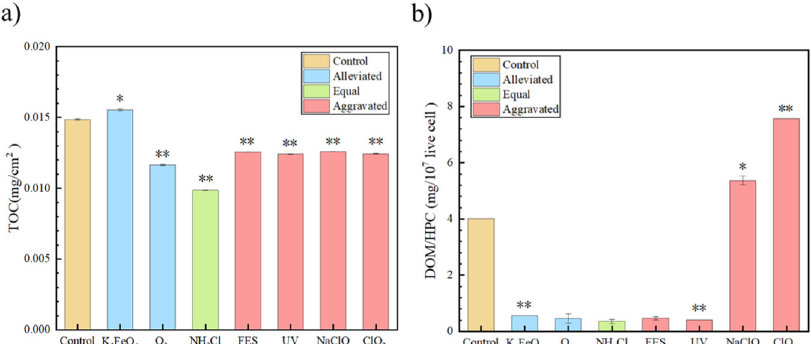
Fig. 2 DOM density in the DRB bio fi lms (32 days). a DOM content and b the ratio of the ratio of DOM to HPC in the bio fi lms. The experiment was conducted in parallel in three sets. Error bars represent the standard deviation for three independent experiments. The p value was generated by t test (* p < 0.05, ** p < 0.01).